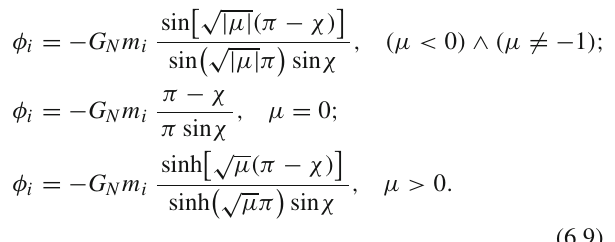
and corresponds to the zero value of ν . Obviously, for ν = 0 the transformation (3.4) does not work. Schematic location of the special values (6.2) and (6.3) of the scale factor is depicted in Fig.